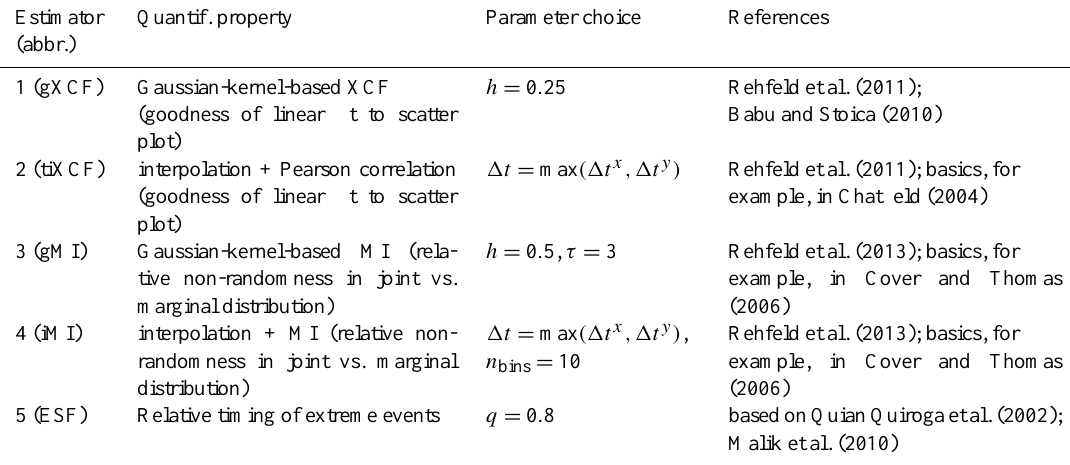
Table 1. Properties, parameters and references of the similarity estimator algorithms for irregularly sampled time series developed and tested in this